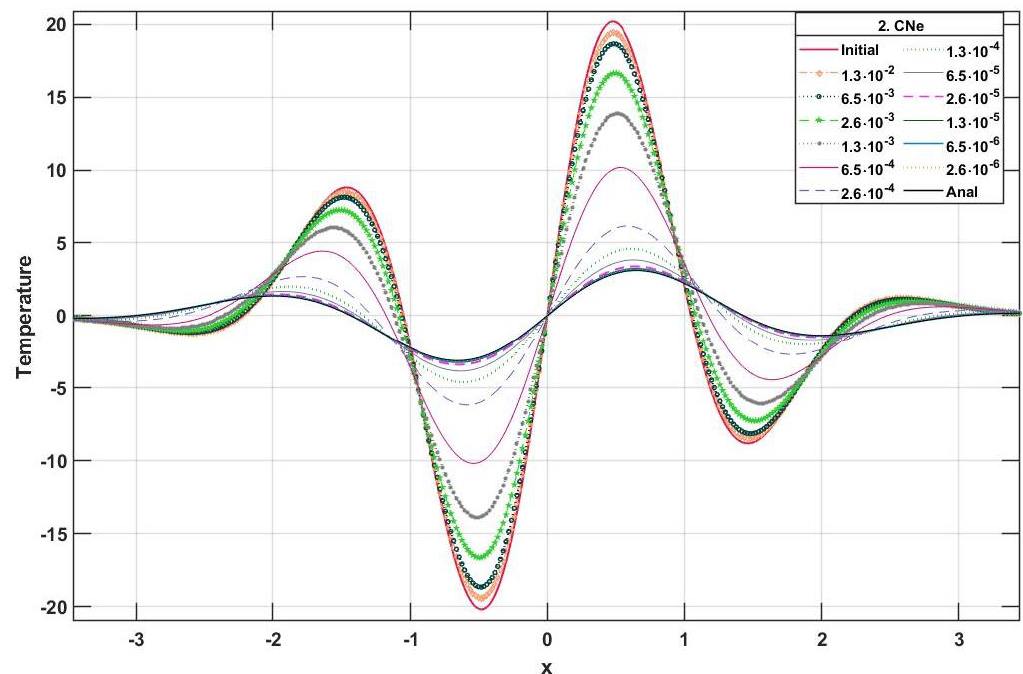
Figure 4. The numerically calculated temperatures u for the three-stage CNe method as a function of the space variable x for different time step sizes in Experiment 1. The red and the black solid lines are for the initial and the analytically calculated temperatures, respectively.